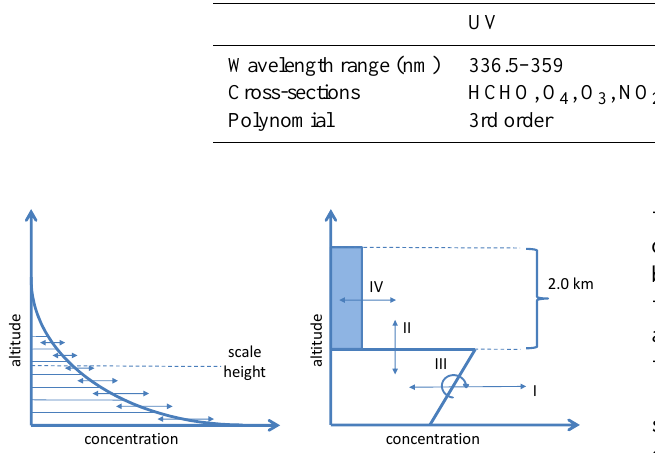
Figure 1. Schematic of profile parameterizations for methods A (left) and B (right). Method A uses 13 layers (not drawn) between 0 and 4km. The number of free variables for method B varies, see Table